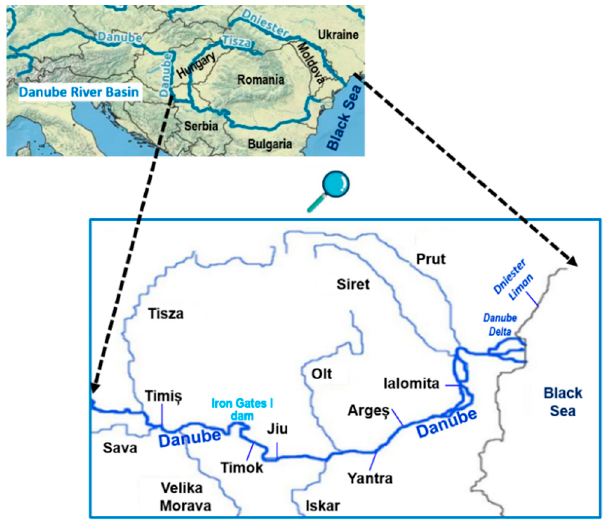
Figure 1. The study area in the Danube River and NW Black Sea Basins.